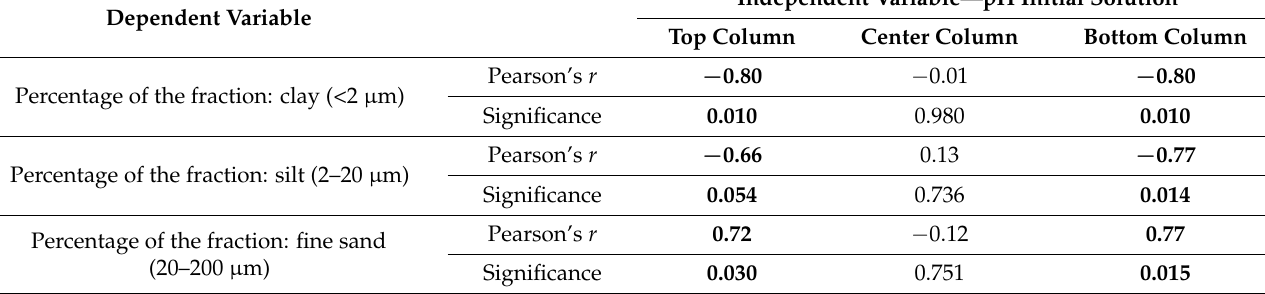
Table 7. Correlation of initial pH with percentage content of grains from selected fractions by the location from which the sample was